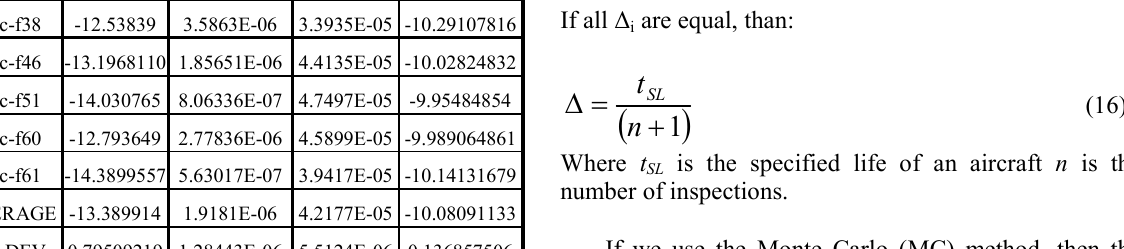
Table 5. Calculations of averages and STD for ln Q and a (0) n SPECIMEN b 0 =ln a (0) expb 0 = a (0)